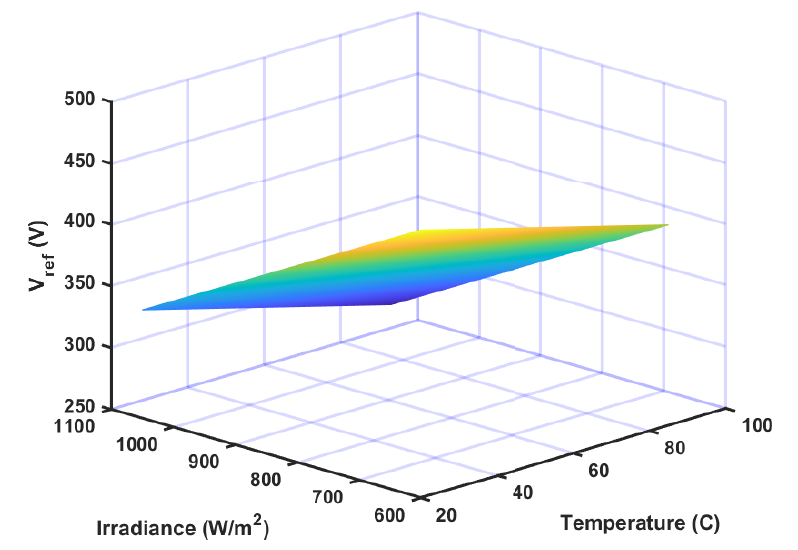
Figure 7. V ref generation for varying level of irradiance and